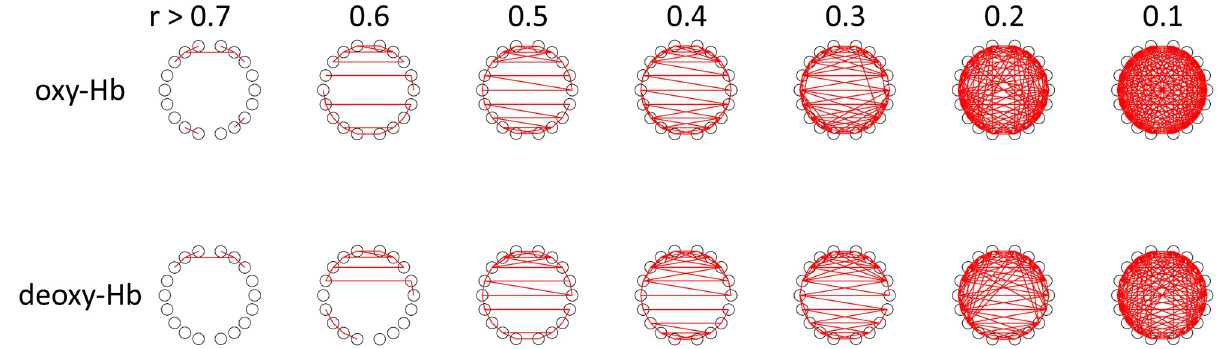
Fig 19. Functional connectivity in the frequency range 0.01–0.1 Hz computed by correlation coefficients. The numbers at the top represent the correlation coefficients of the thresholds. Upper: oxy-Hb, lower: deoxy-Hb.